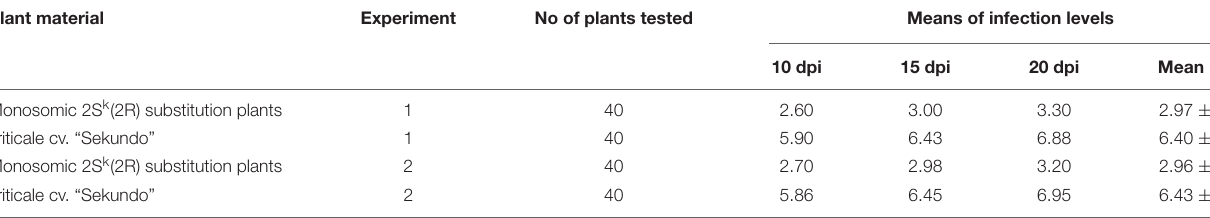
F ratio = 1,267.62 ( Supplementary Table 1 ).